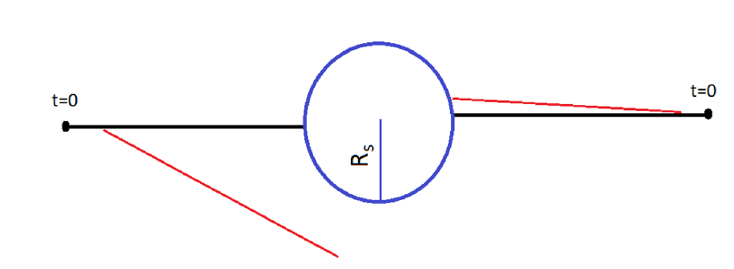
Figure 6. Scattering of two energetic gravitons, resulting in the formation of a graviball of radius R s . The red lines represent soft emissions. The emission in the left will contribute to the energy loss, leading to the reduction of the Schwarzschild radius R 0 ! R s < R 0 , where R 0 would have been the Schwarzschild radius in the absence of